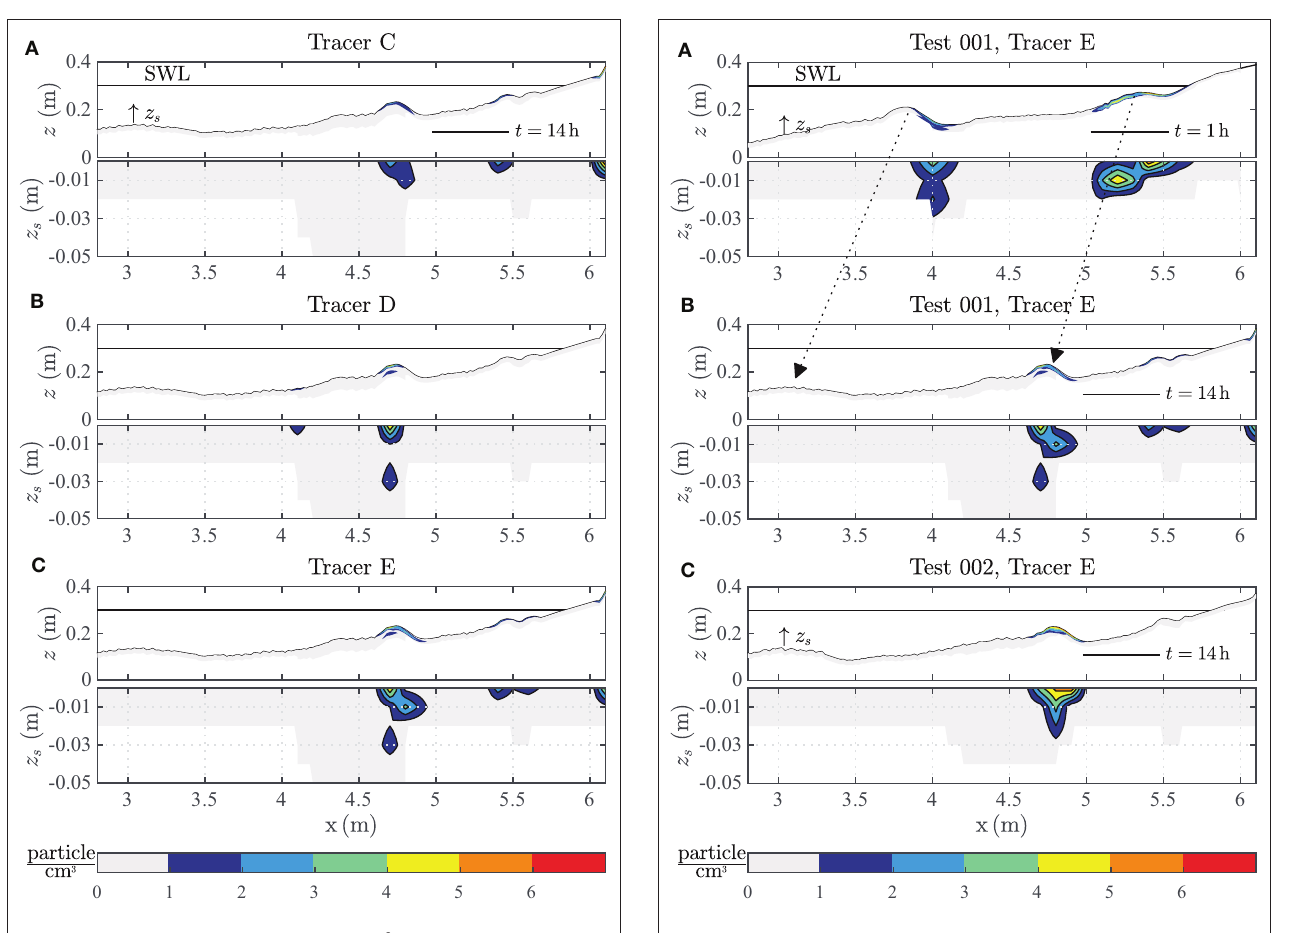
FIGURE 6 | Microplastic distribution (particle/cm 3 ) below the beach profile surface of (A) the tracer “C,” (B) tracer “D,” and (C) tracer “E” (each diameter 0.68mm). =